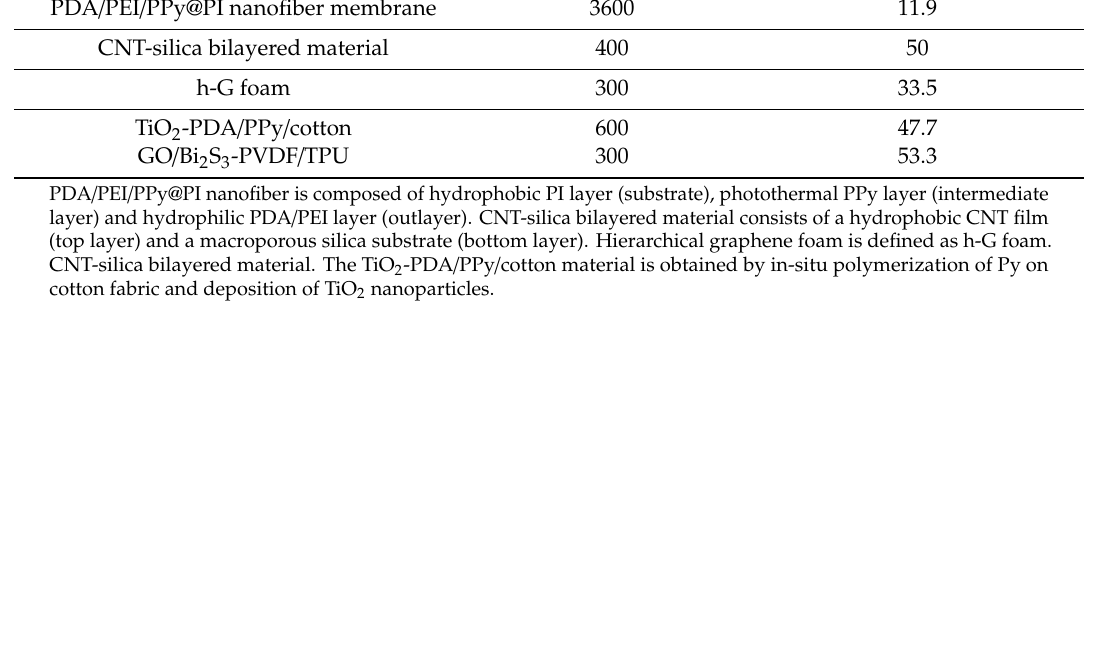
Figure 8. ( a ) Temperatures on the surface of different membranes under irradiation. ( b ) Temperature of five cycles. ( c ) Infrared images of the GO/Bi 2 S 3 -PVDF/TPU membrane under irradiation. Table 2. Temperature changes in various membranes under the same irradiation intensity. Samples